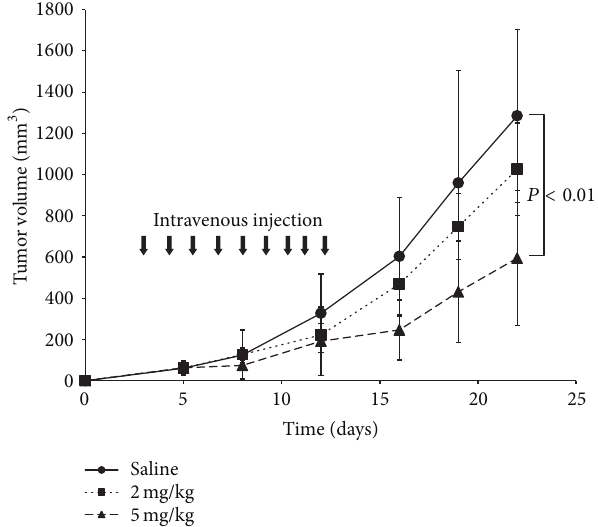
Figure 4: Antitumor activity of IL-4R 𝛼 -lytic hybrid peptide in tumor xenograft model in vivo . TGBC-44-TKB were implanted subcutaneously into athymic nude mice. Intravenous injection of saline and IL-4R 𝛼 -lytic hybrid peptide (2mg/kg or 5 mg/kg) is indicated by the arrows. Data are expressed as mean ± SD ( 𝑛 = 6 animals in each